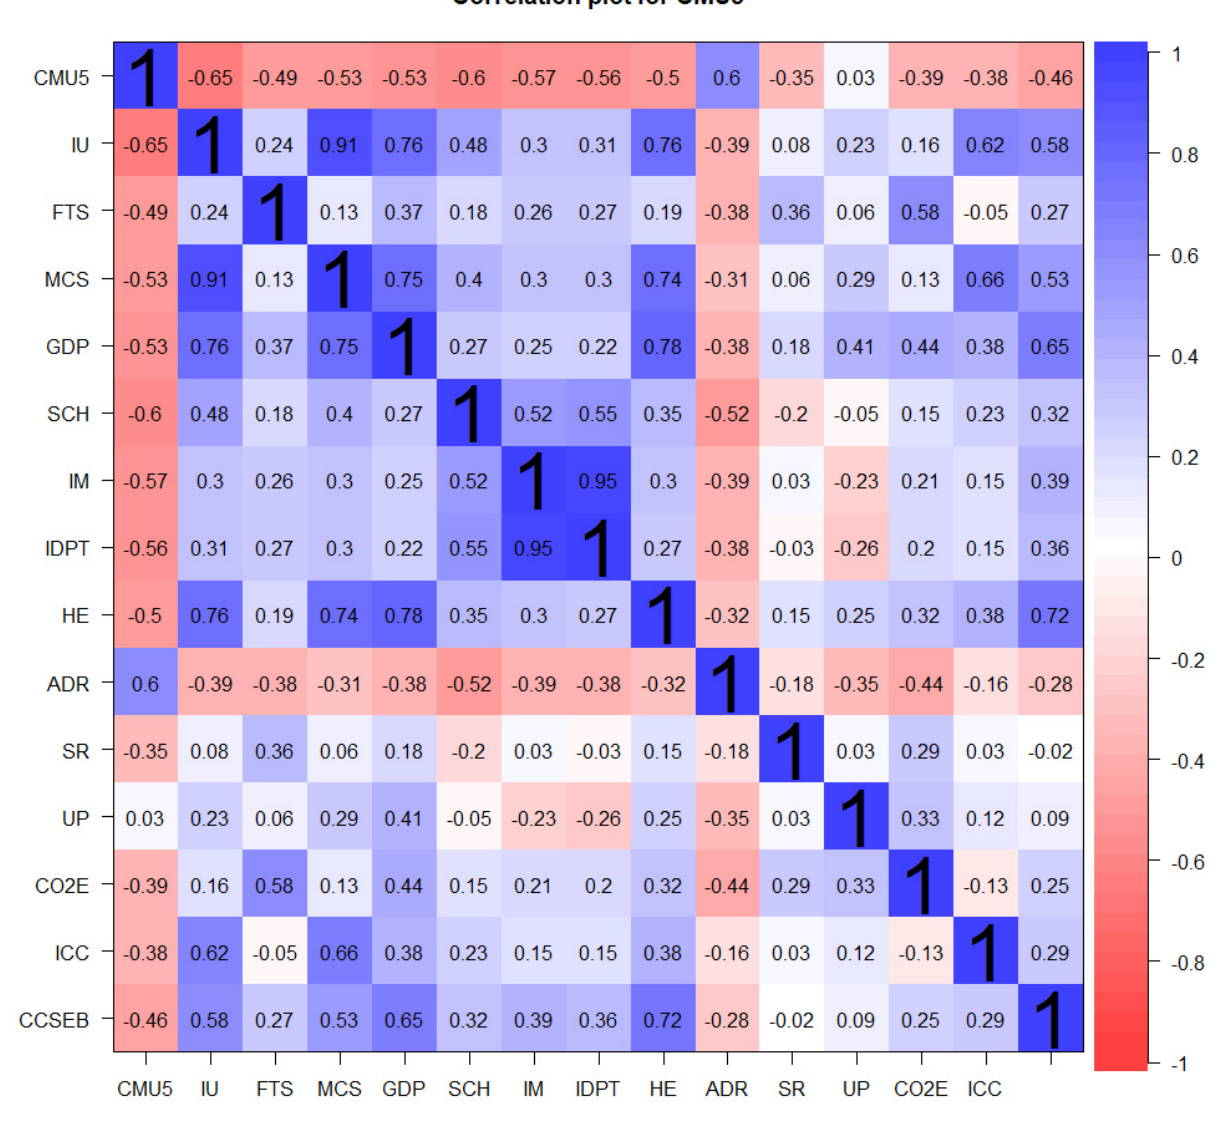
Figure A1. Spearman correlation matrix of the dependent (INFM in the top, CMU5 in the bot- tom) health variables, independent ICT Variables, and socio − economic and environmental control variables.